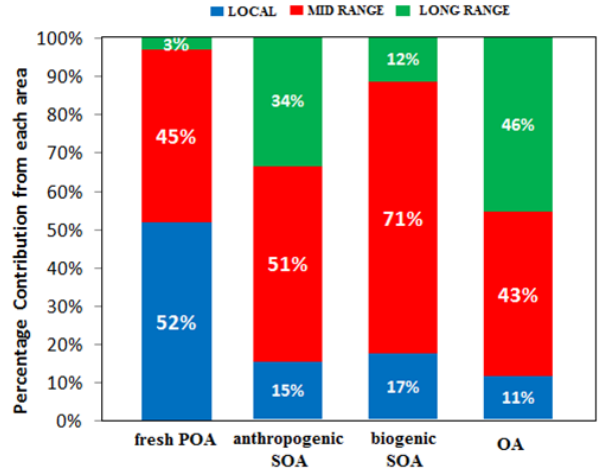
Fig. 4. Percent contributions from each transport category (local, mid-range and long-range) for different types of organic aerosol during the summer. Long range OA also includes the transported OA into the domain.